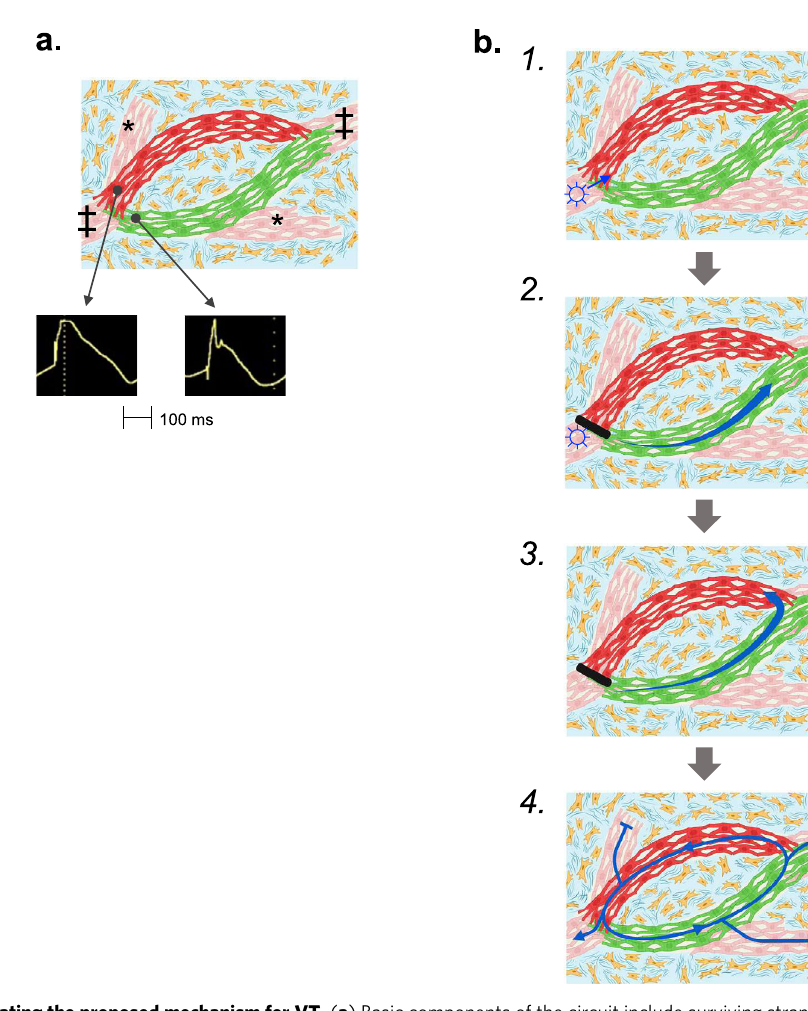
green myocytes) interrupted by areas of fi brosis (blue areas with yellow fi broblasts). A strand of myocytes with shorter APDs (green) is adjacent to a strand of myocytes with longer APDs (red). The circuit connects to the rest of the heart ( ‡ ) and may connect to dead-end segments (*). b 1. VT starts with a premature beat ( ☼ ) that conducts through the surviving myocardial tissue strands until reaching a junction between short and long APD tissues. 2. If appropriately timed, the premature beat continues to conduct down the path with shorter APDs that has recovered excitability (green myocytes) and blocks in the path with longer APDs that is still refractory (red myocytes). 3. When the excitation wavefront reaches the distal connection between the two limbs of the circuit, it continues to conduct back up the long APD limb if that path has recovered excitability. 4. It then continues to conduct in a reentrant manner around the